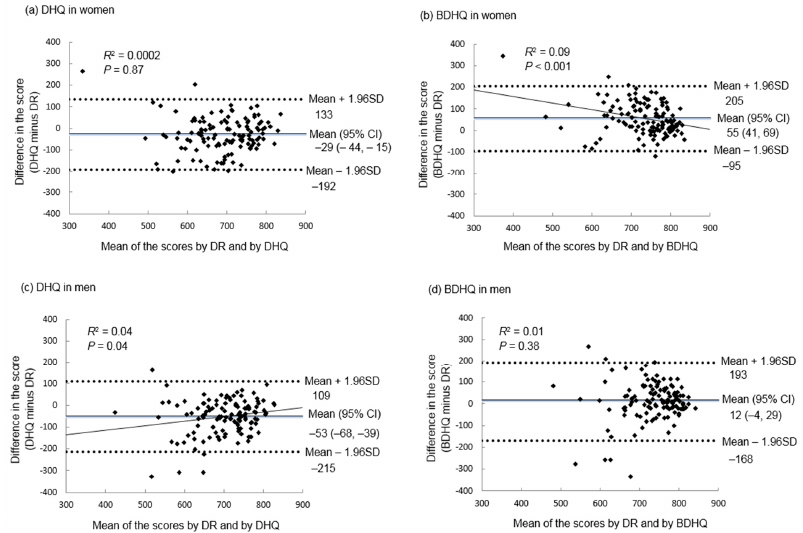
Figure 2. Bland–Altman plots assessing the agreement between the total score of the Nutrient-Rich Food Index 9.3 estimated by a 16-day weighed dietary record (DR) conducted over a year and that estimated by a comprehensive diet history questionnaire (DHQ) or by a brief diet history questionnaire (BDHQ) in Japanese women ( n = 121; ( a ) DHQ and ( b ) BDHQ) and men ( n = 121; ( c ) DHQ and ( d ) BDHQ). In each season, a 4-day weighed DR was conducted: November and December 2002 (autumn), February 2003 (winter), May 2003 (spring) and August and September 2003 (summer). For each individual, the mean value of the 16-day data was used. The DHQ and BDHQ used in this analysis were conducted before the period of the DR (November 2002). A regression line was added when it was statistically significant ( p < 0.05).